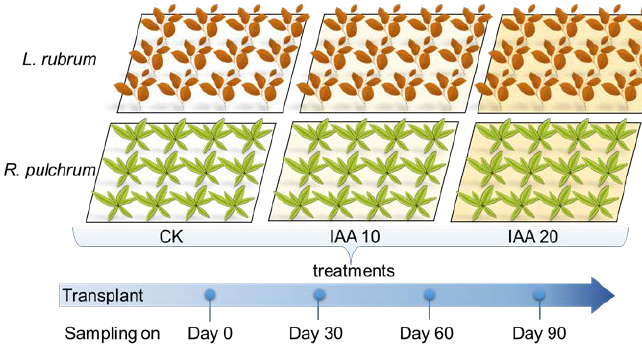
Figure 1. The schematic of experiment design and sampling.